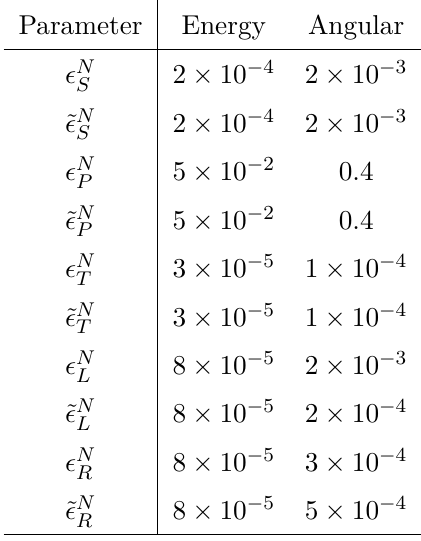
Table 4 . Projected sensitivity at 95% CL on the coupling constants of exotic currents of a sterile neutrino with mass m N = 10 keV. The sensitivity assumes 10 18 events in either the energy or angular